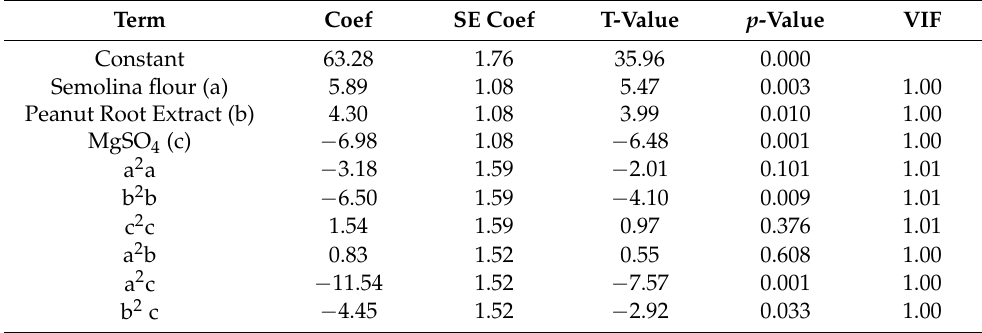
Table 3. Coded coefficients for antifungal activity against P. arachidichola